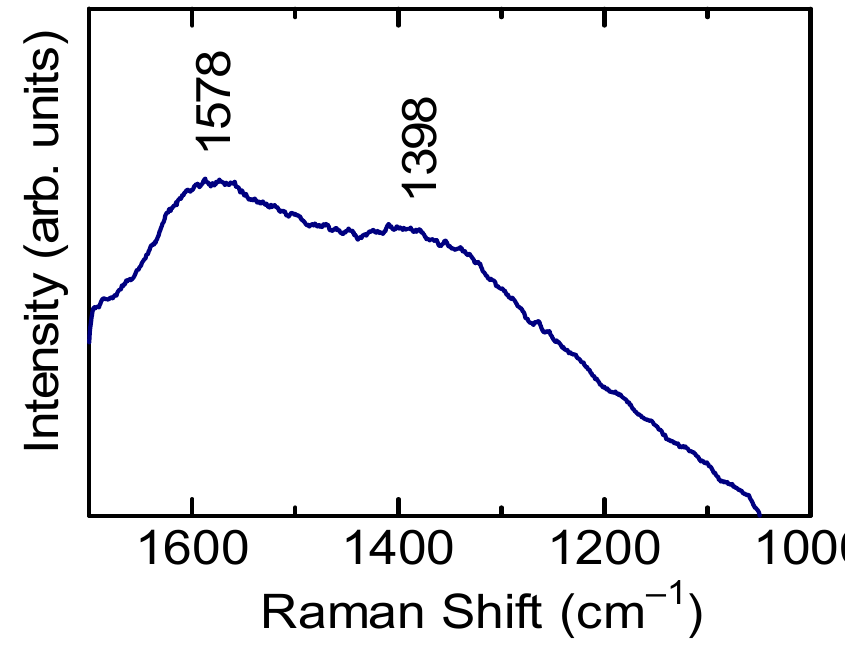
Figure 10. Raman spectrum for V-CB(PANI).